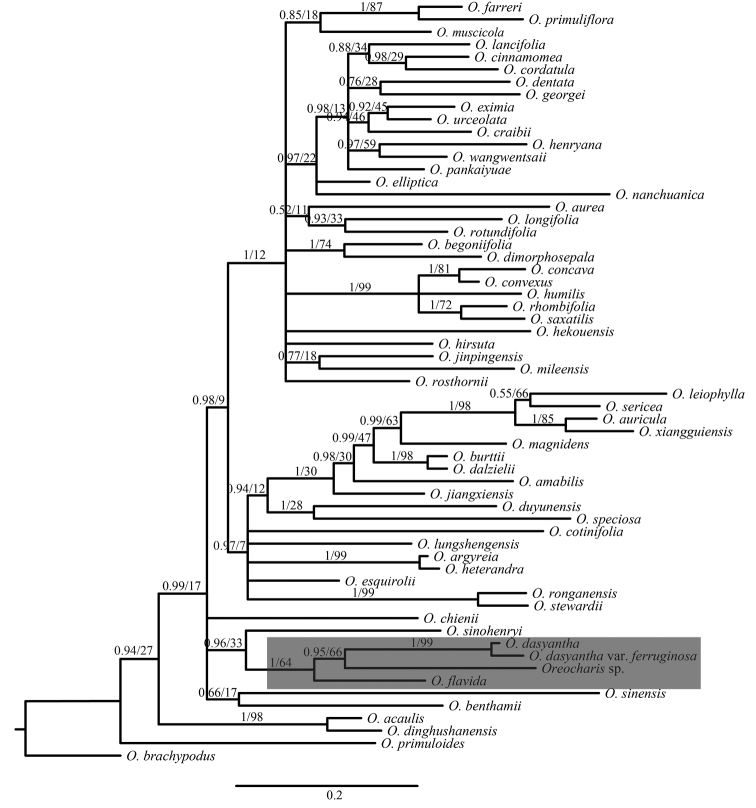
Molecular phylogeny for Hainan Oreocharis taxa and 57 Oreocharis species based on combined ITS1/2 and trnL-trnF, there was no significant incongruence based on the incongruence length different (ILD) test between the ITS1/2 and trnL-trnF. Bayesian posterior probability (PP) and ML bootstrap values (BS) are showed above branches. Hainan Oreocharis taxa were showed in grey.